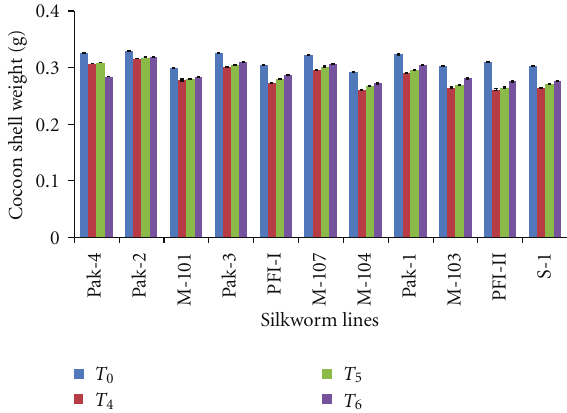
Figure 5: Comparative performance of cocoon shell weight (mean ± SE) eleven silkworm lines at 30 ± 1 ◦ C in combination with 55, 65, and 75% RH and controlled conditions of temperature and RH (25 ± 1 ◦ C and 70–80%,